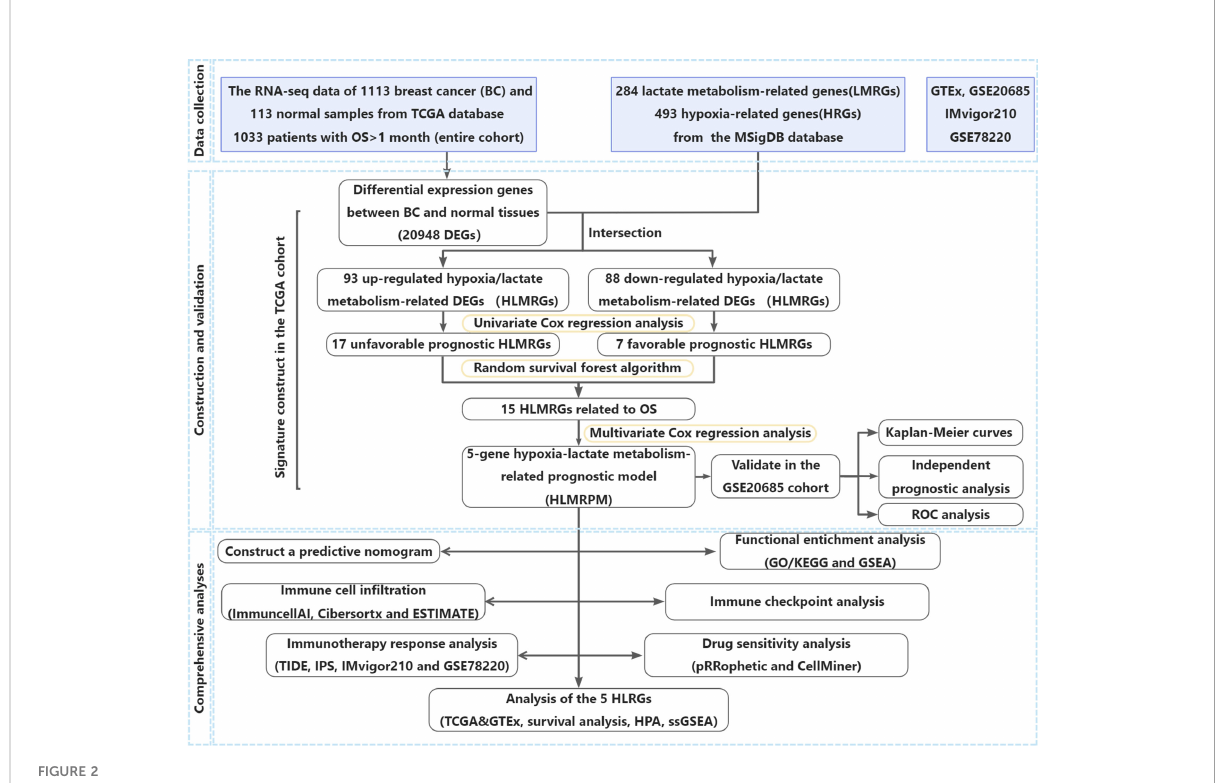
FIGURE 2 The fl ow of the